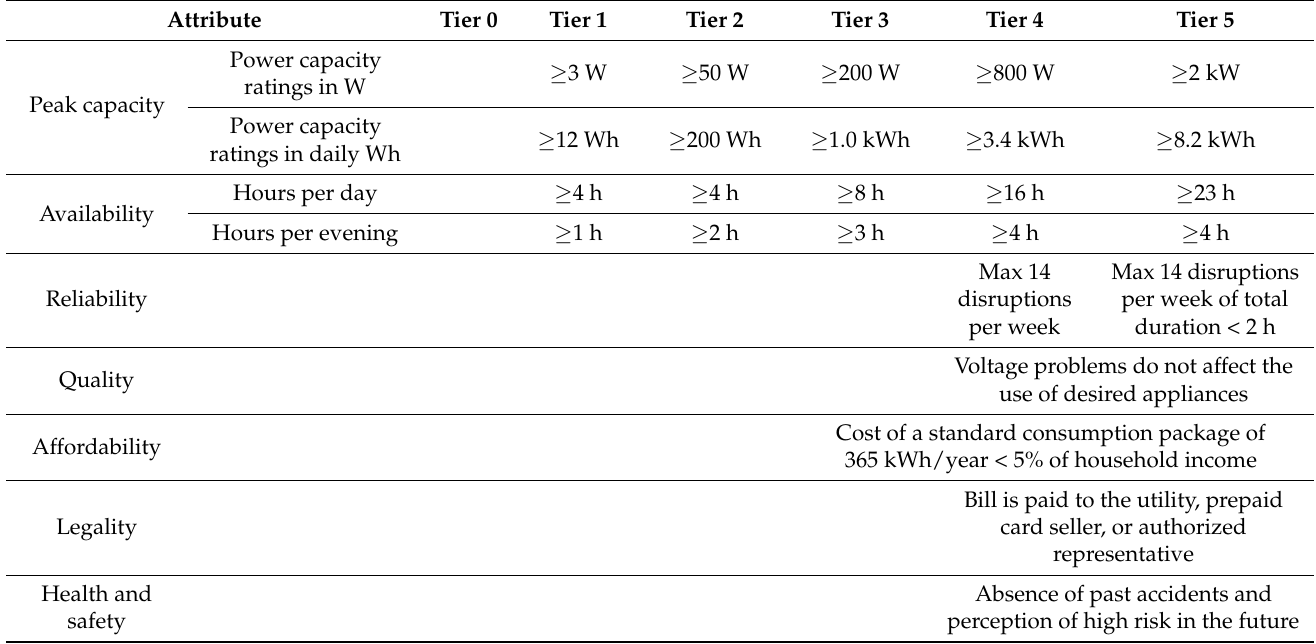
Table 1. Multi-tier framework (MTF) for measuring access to household electricity supply